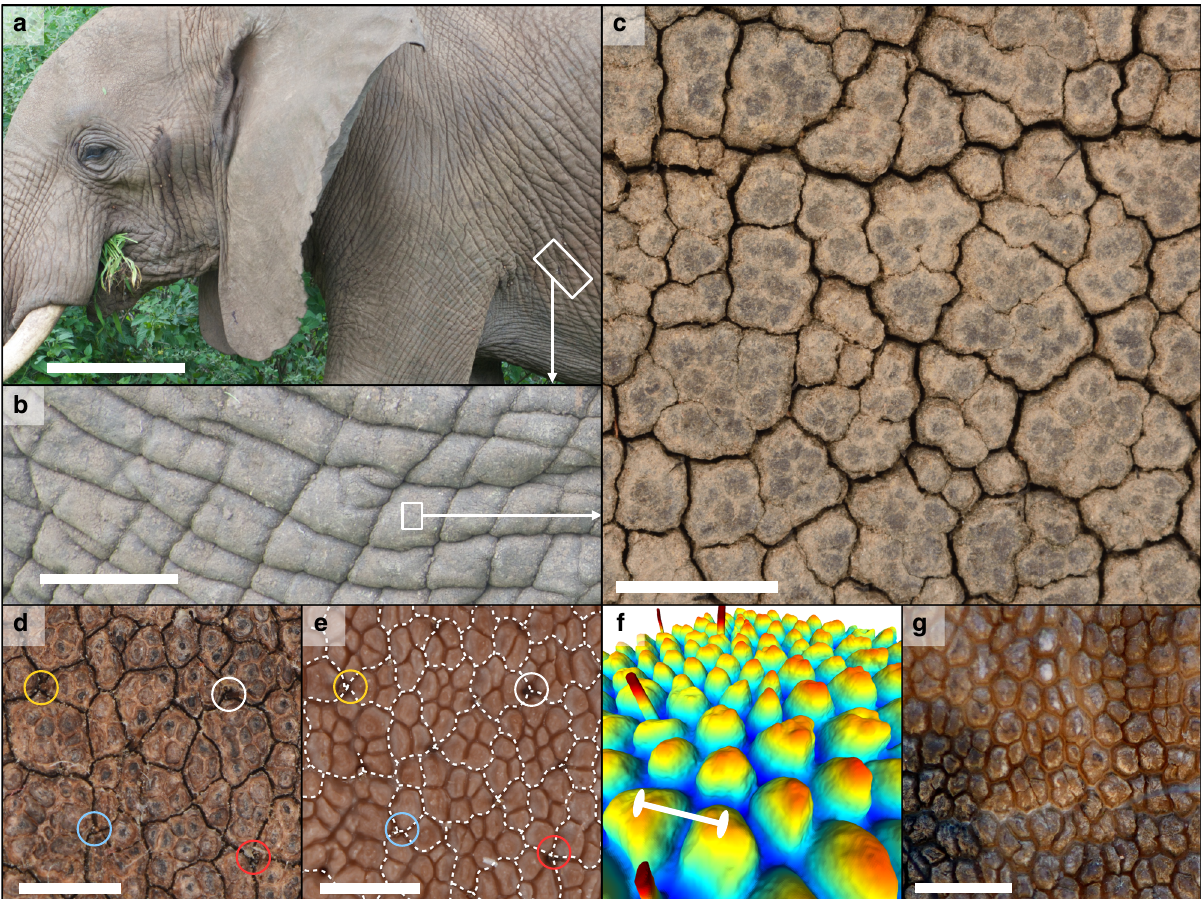
Fig. 1 Morphology of the African bush elephant ’ s ( Loxodonta africana ) skin. In addition to a , b centimetre-scale wrinkles and folds, African elephants exhibit c a network of narrow (~100 μ m) channels (here, on the forehead of a juvenile animal). Previous research shows that these structures help the animal retain water and mud on its skin. d , e A patch of forehead skin before ( d ) and after ( e ) the mechanical extraction of the stratum corneum . In e , the narrow channels (white dotted lines) are no longer visible because they are con fi ned to the extracted skin layer; note that the stratum corneum channels are con fi ned in between papillae. The circled hair on both pictures serve as guides to the eye. f Mesh generated from the data of a micro-CT scan of a patch of skin without stratum corneum and colour-coded by height, showing the intricate three-dimensional surface geometry of the animal ’ s papillae. g A patch of skin from the forehead of an Asian elephant. Even though the pattern of papillae is present, narrow channels are not observed. Scale bars: a ∼ 50 cm; b ∼ 7 cm; c 7.5 mm; d 2.5 mm; e 2.5 mm; f 1 mm; g 5